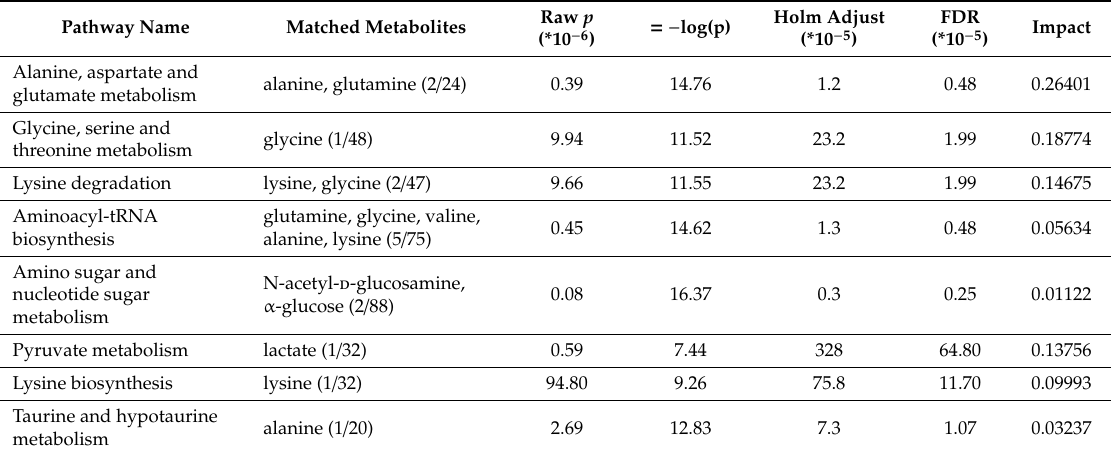
Table 3. Metabolic Pathway Analysis for serum metabolites of ADV and EAR HCC